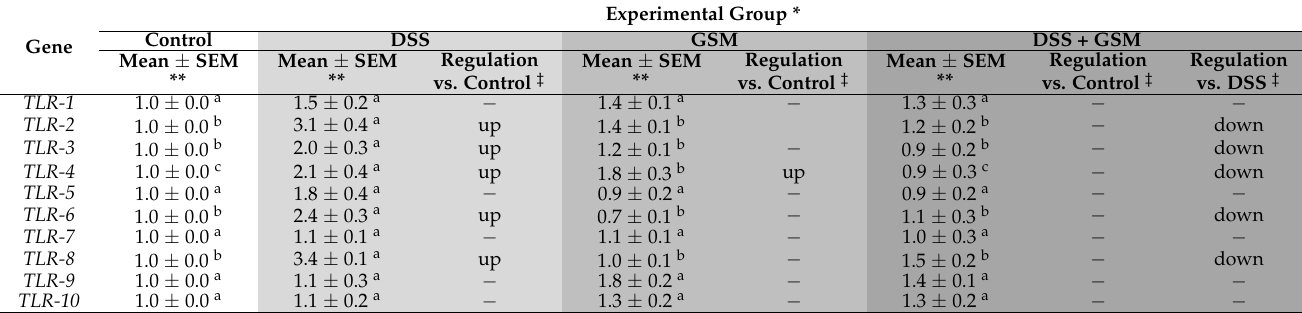
Table 2. The effects of GSM diet on Toll-like receptors (TLRs) gene expression in the colon of DSS-treated piglets.